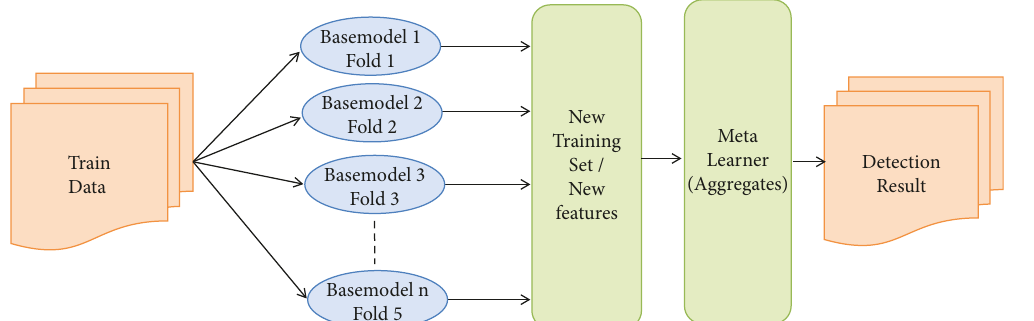
Figure 6: Model stacking (LR aggregating input).